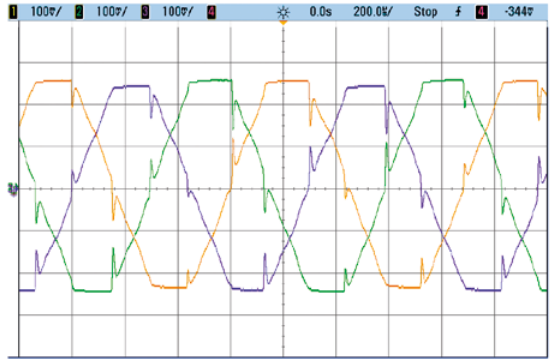
Fig. 4. Output voltage waveforms of the inverter